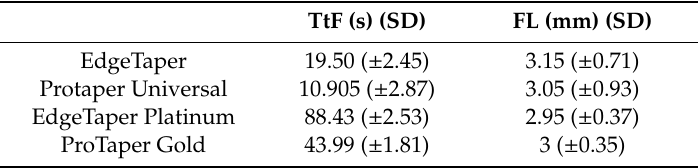
Table 1. Mean and standard deviation of time to fracture (TtF) and length of the fractured fragments (FL).